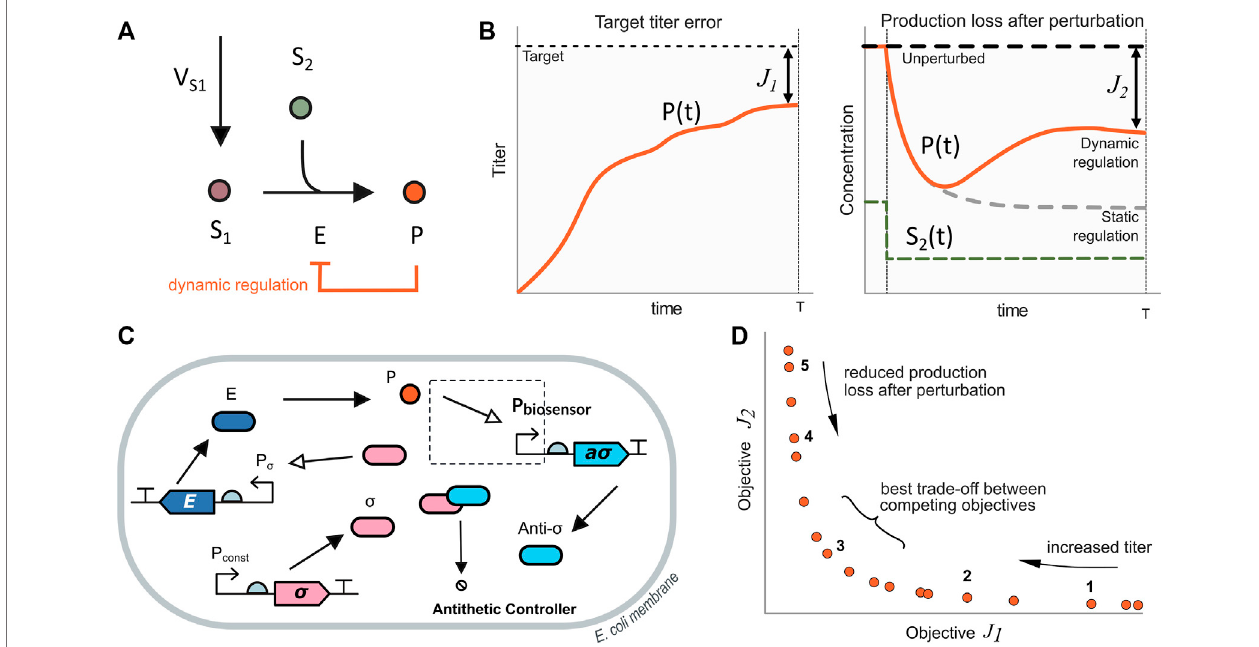
FIGURE1| Illustrativemodelsystem. (A) Metabolicpathwayfortheproductionofmetabolite P .Themainsubstrate S 1 andthesecondaryone S 2 areconvertedinto the product P by the catalyst enzyme E . In the static regulation strategy (black lines), the expression level of the enzyme E remains constant in time. Conversely, in the dynamic regulation strategy (orange line), the expression of the enzyme E depends on the amount of product P . (B) Objective functions employed in this work for the maximization of the production up to a target value ( J 1 ) together with the minimization of the production loss after perturbations ( J 2 ) as de fi ned in Eq. 9 , 10 (C) Biosensorandantitheticcontrollercon fi gurationfordynamic pathwayregulation.Theamountoffree σ moleculedeterminestheexpressionoftheenzyme E .ATF-based biosensordetects theproductlevelsandcounteractsexpressing theanti- σ molecule.Whentheamountof P decreases,thecontrollerreduces theamount ofexpressed anti- σ ,thusincreasingtheamountoffree σ toup-regulatetheenzyme E . (D) Paretofrontofoptimal solutionsforthedynamicalpathway regulationcase.Solutionsonthe right side have large titer target error J 1 (i.e., lower titer) and a small production loss after perturbation J 2 (i.e., higher titer after the perturbation). Moving along the Pareto front towards the left, the titer target error decreases, and the production loss increases. Solutions in the middle of the Pareto front have the best trade-off between the competing objectives